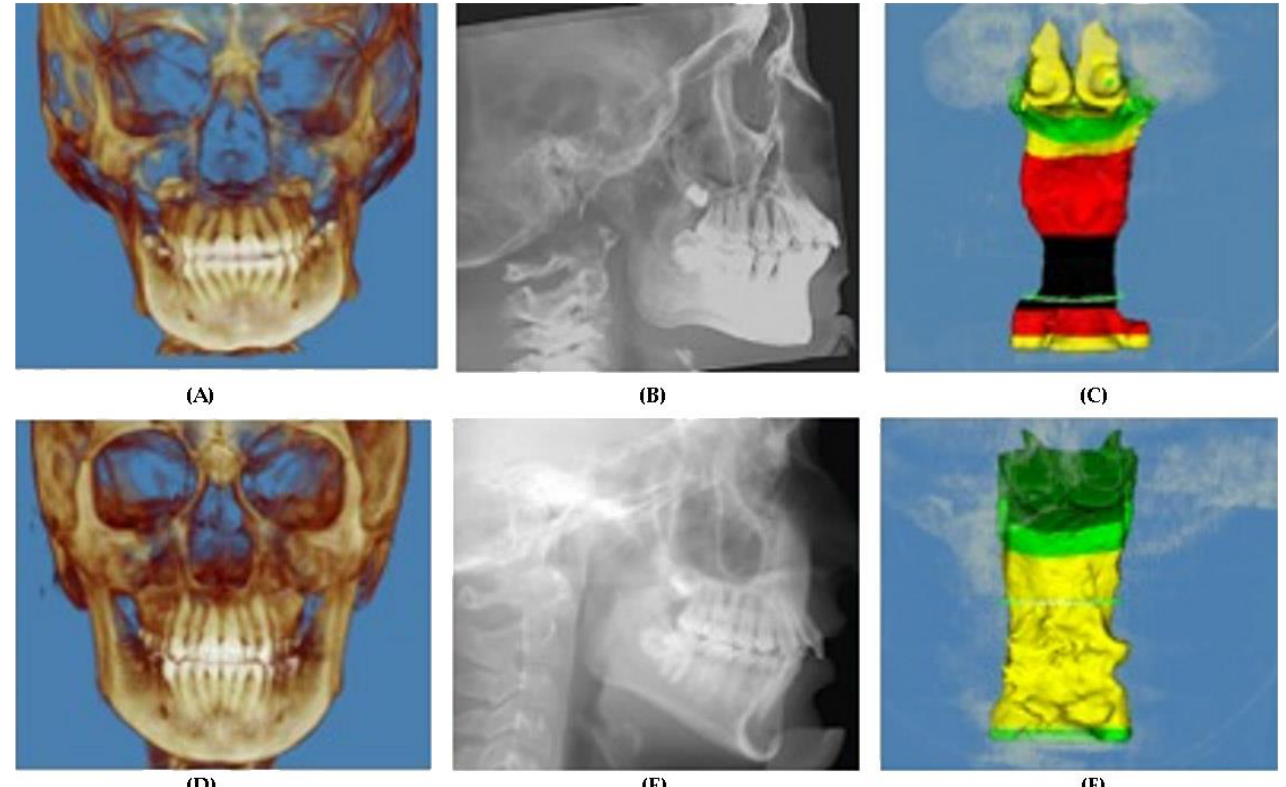
Figure 4. ( A – C ) Images from a JIA patient with a chin deviation to the left side and an asymmetric airway with a “twist” effect. ( D – F ) Images of a control patient representative of the control group with no skeletal asymmetry and an airway with no gross asymmetries.